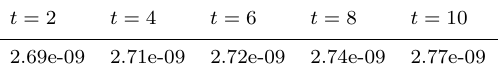
Thirdly, we take the test